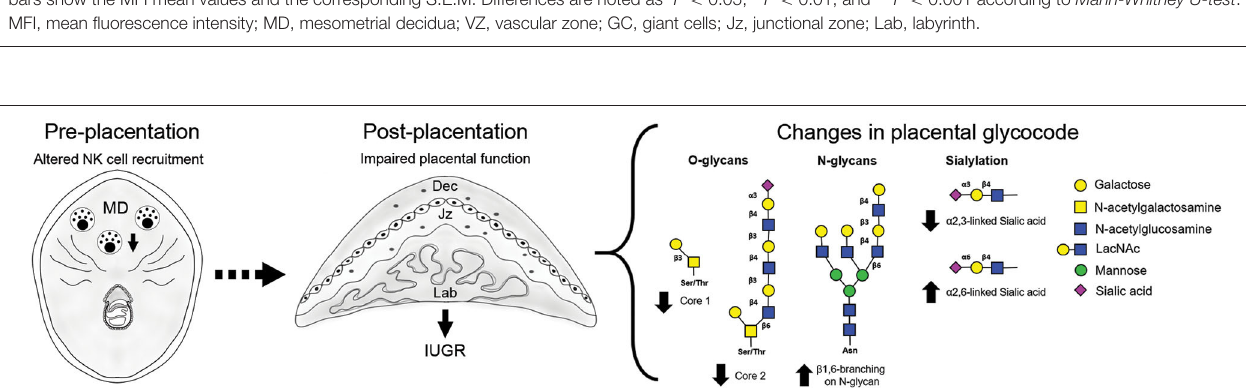
Frontiers in Immunology | www.frontiersin.org